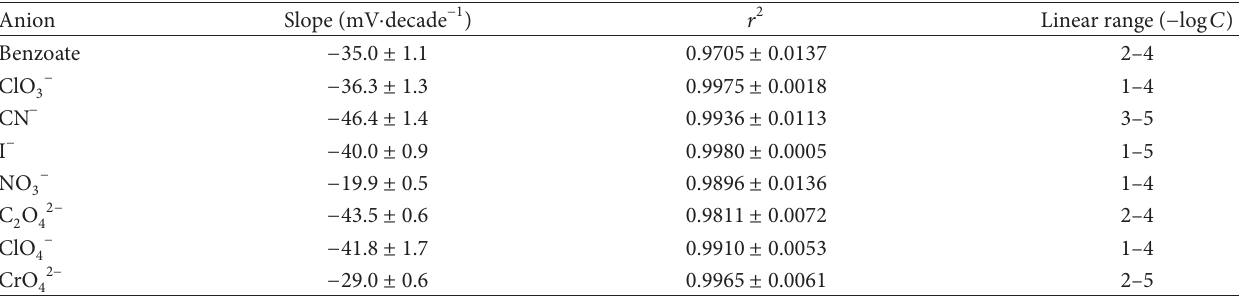
T 1: Potentiometric response of the SMZ-PVC electrode toward different anions ( solution of the corresponding anion for 2h at 25 (membrane includes 4